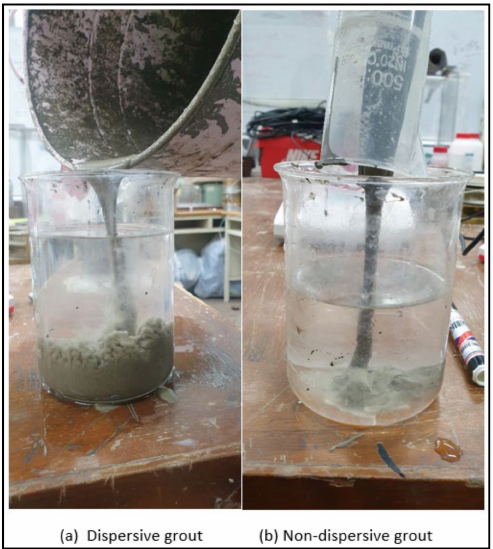
Figure 6. ( a ) Dispersive and ( b ) non-dispersive grouts testing. Based on the standard 200 to 300 mm slump spread and the best flowable grout, for the mini slump spread, an open-ended flow cylinder with dimension of 75 mm × 150 mm was used to measure the spread of the grout [12]. The spread of the grout was measured along two directions, both perpendicular to each another, and the average of the spread was noted (see Figure